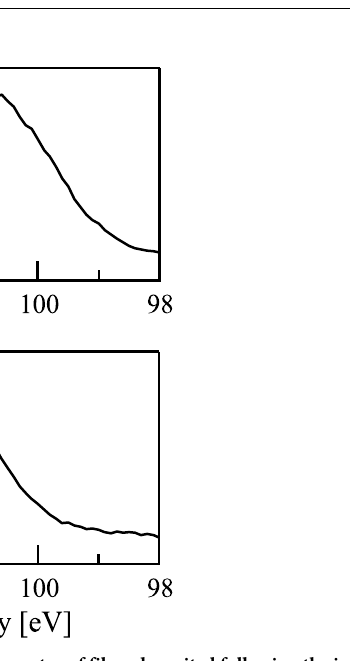
Fig 9. Si2p X-ray photoelectron spectroscopy spectra of films deposited following the injection of (a) Ar + and (b) N + ions to Si substrates in conjunction with hexamethyldisilazane. Substrate temperature during the deposition experiments was 540